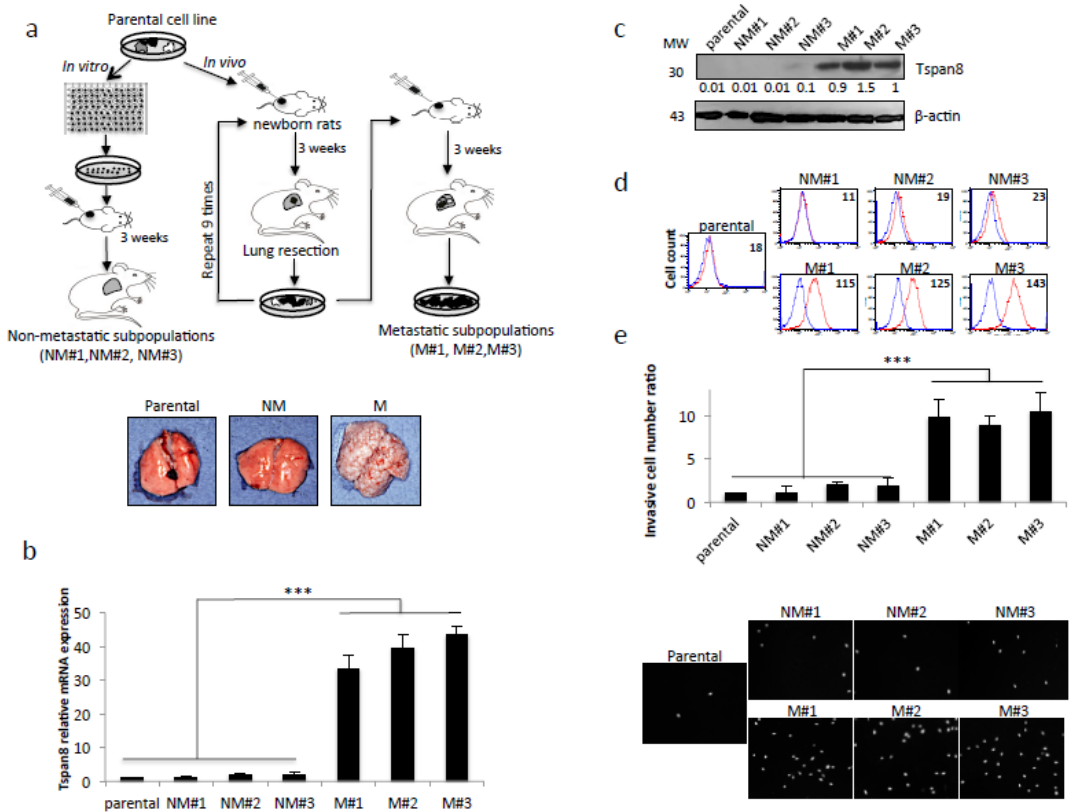
Figure 1. Generation of potent metastatic cell subpopulations expressing the metastatic-associated Tspan8 protein. ( a ) Schematic diagram of the experimental procedure used to sequentially select in an immunosuppressed new-born rat model cell subpopulations with progressively higher metastatic ability from a poorly metastatic melanoma cell line. Lower panel, representative photographs of the rat lungs. ( b ) The parental human M4Be cell line and its derived non metastatic (NM#1-3) and metastatic (M#1-3) subpopulations were examined for TSPAN8 mRNA levels by QPCR. Expression normalized to GAPDH represented a fold change of control sample ( n = 3; ± SD); ( c ) Western blot analysis of Tspan8 expression with β -Actin as loading control and reference for quantification (one representative experiment of three), uncropped western blots figures in Figure S1; ( d ) Tspan8 cell surface expression by flow cytometry analysis. In red, the specific staining and in blue the isotype-matched control antibody (one representative experiment of three). Numbers indicate Mean Fluorescence Intensity (MFI). ( e ) Matrigel invasion assay using transwell chambers. The total number of invasive cells was integrally counted by scanning microscopy and normalized to the value from control parental cell line ( n = 3; ± SEM). Representative visual fields are illustrated beneath. *** p < 0.001.